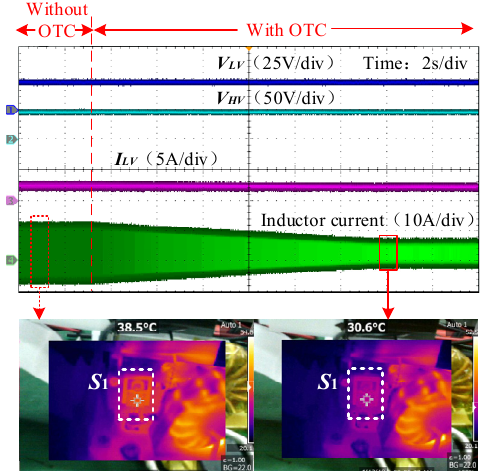
Figure 14. Experimental waveforms in V LV = 24 V, half load.